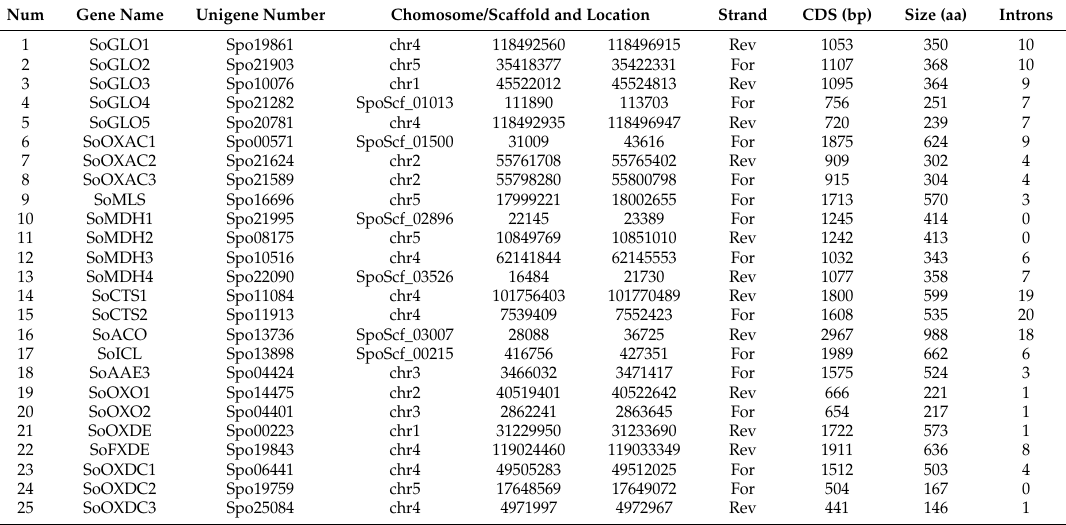
Table 1. Putative oxalate related genes and the information of each